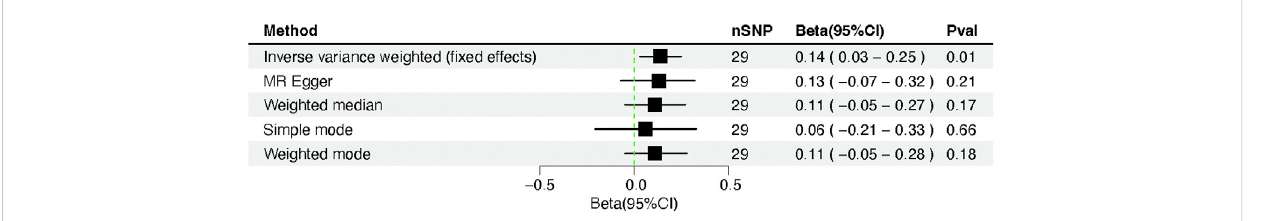
FIGURE 3 Forest plot of Mendelian randomization analysis between COVID-19 severity (hospitalization) and cardiac injury risk.